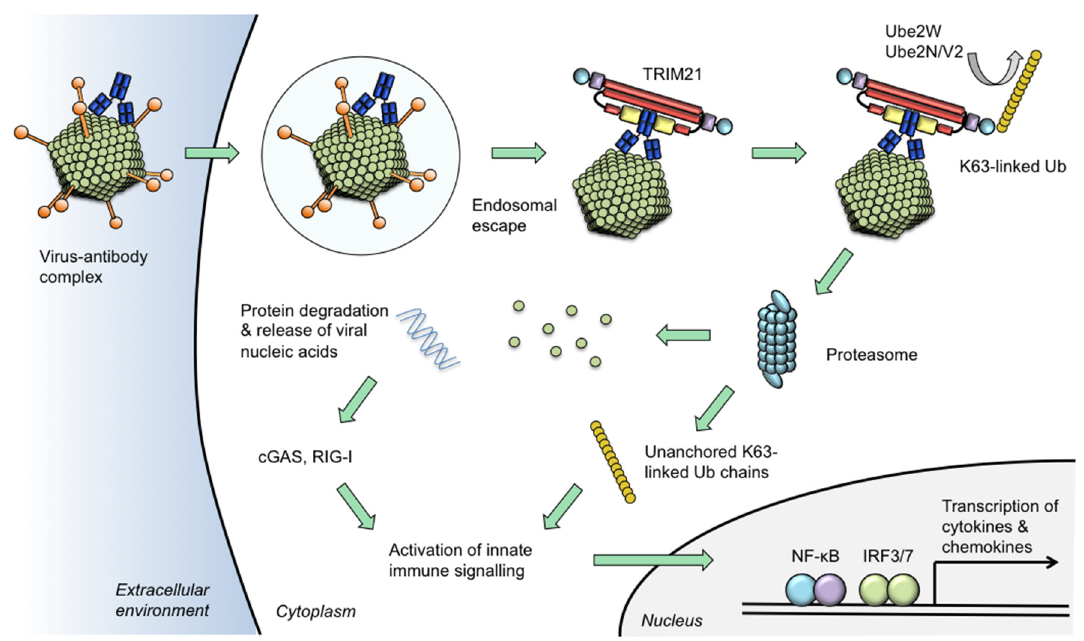
Figure 2. Model of TRIM21 neutralization and signalling activities. Certain viruses traffic antibodies attached to their capsids into the cytoplasm following escape from the endosome. Intracellular antibodies are bound by TRIM21 at 1:1 stoichiometric ratio. TRIM21 catalyses its auto-ubiquitination via mono-ubiquitination by Ube2W and K63-linked chain extension by Ube2n/Ube2V2. The proteasome degrades viral components causing the neutralization of infection. Concurrent with degradation, unanchored ubiquitin chains are released via the activity of proteasome-resident de-ubiquitinating enzyme POH1. Activation of NF- κ B and IRF3/7 ensues which is attributable to both a direct effect of TRIM21 and through the release of viral genomes which are detected by nucleic acid sensors cGAS (for DNA) or RIG-I (for RNA). Activation of innate immune signalling stimulates production of pro-inflammatory chemokines including CCL5 and CXCL10 and cytokines such as IL-6 and interferon- β . In this way, TRIM21 uses intracellular antibody to prevent infection via its neutralization effector mechanism and to induce a transcriptional state that is refractory to viral replication in neighbouring cells.